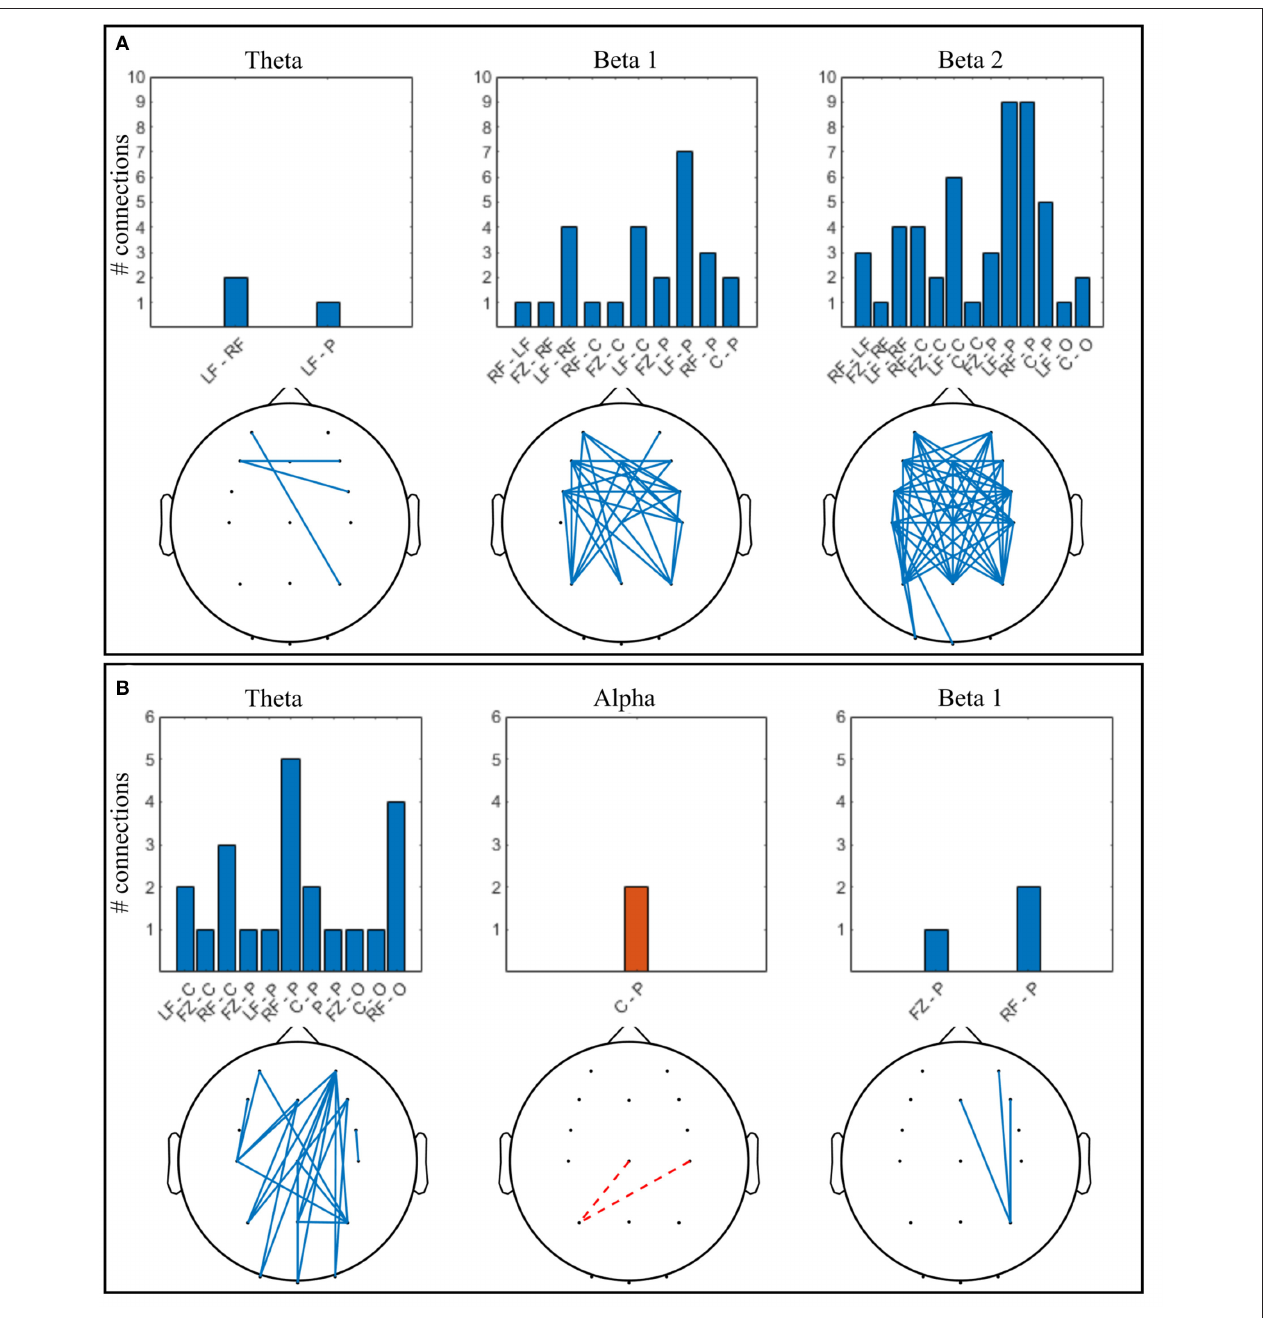
FIGURE 6 | Significant connections in collaborative gaming vs. baseline grand average ( p < 0.01, FDR corrected); theta = 4–7Hz, beta 1 = 13–20Hz, beta 2 = 21–30Hz. Panel (A) dominant (D) players; (B) non-dominant (ND) players. Grouped locations: LF, left frontal; RF, right frontal; C, central; P, parietal; O, occipital and topographical plot; Blue, continuous, increase from baseline; orange, dashed, decrease from baseline.